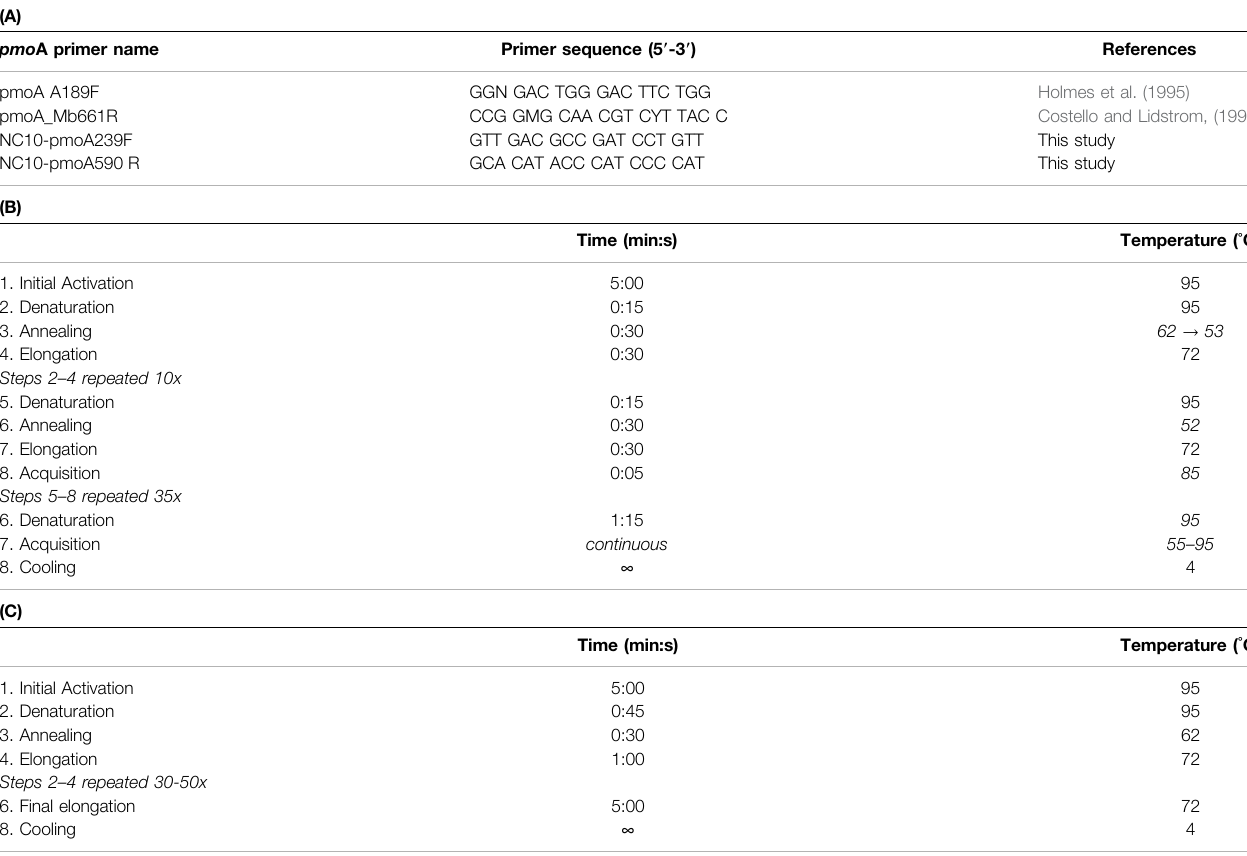
TABLE 2 | (A) pmo A primers used in this study. (B) Protocol for qPCR ampli fi cation using general pmo A primer pair (A189F – Mb661R). During the initial 10 cycles a touch- down PCR was used, during which the annealing temperature decreased in 1 ° C intervals. The same protocol was used for the NC10-pmoA29F/NC10-pmoA590R primer combination except that the annealing temperature was maintained at 62 ° C. (C) PCR ampli fi cation protocols for sequencing. The same protocol was used for both primer